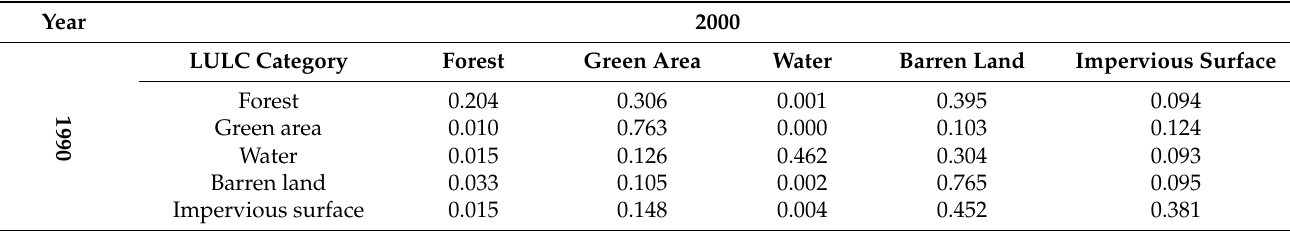
Table 6. Transition matrix from